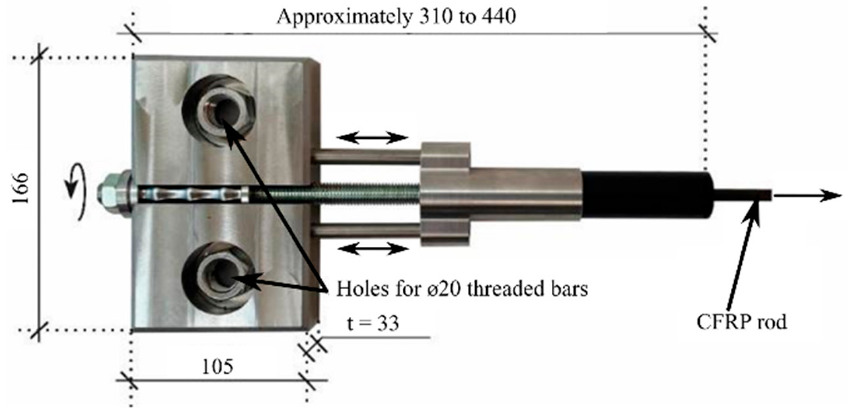
Table 2. Properties of the flexible adhesive. Figure 8. Pre-stressing applied by torque to the end nut on the assembled CFRP anchor system.